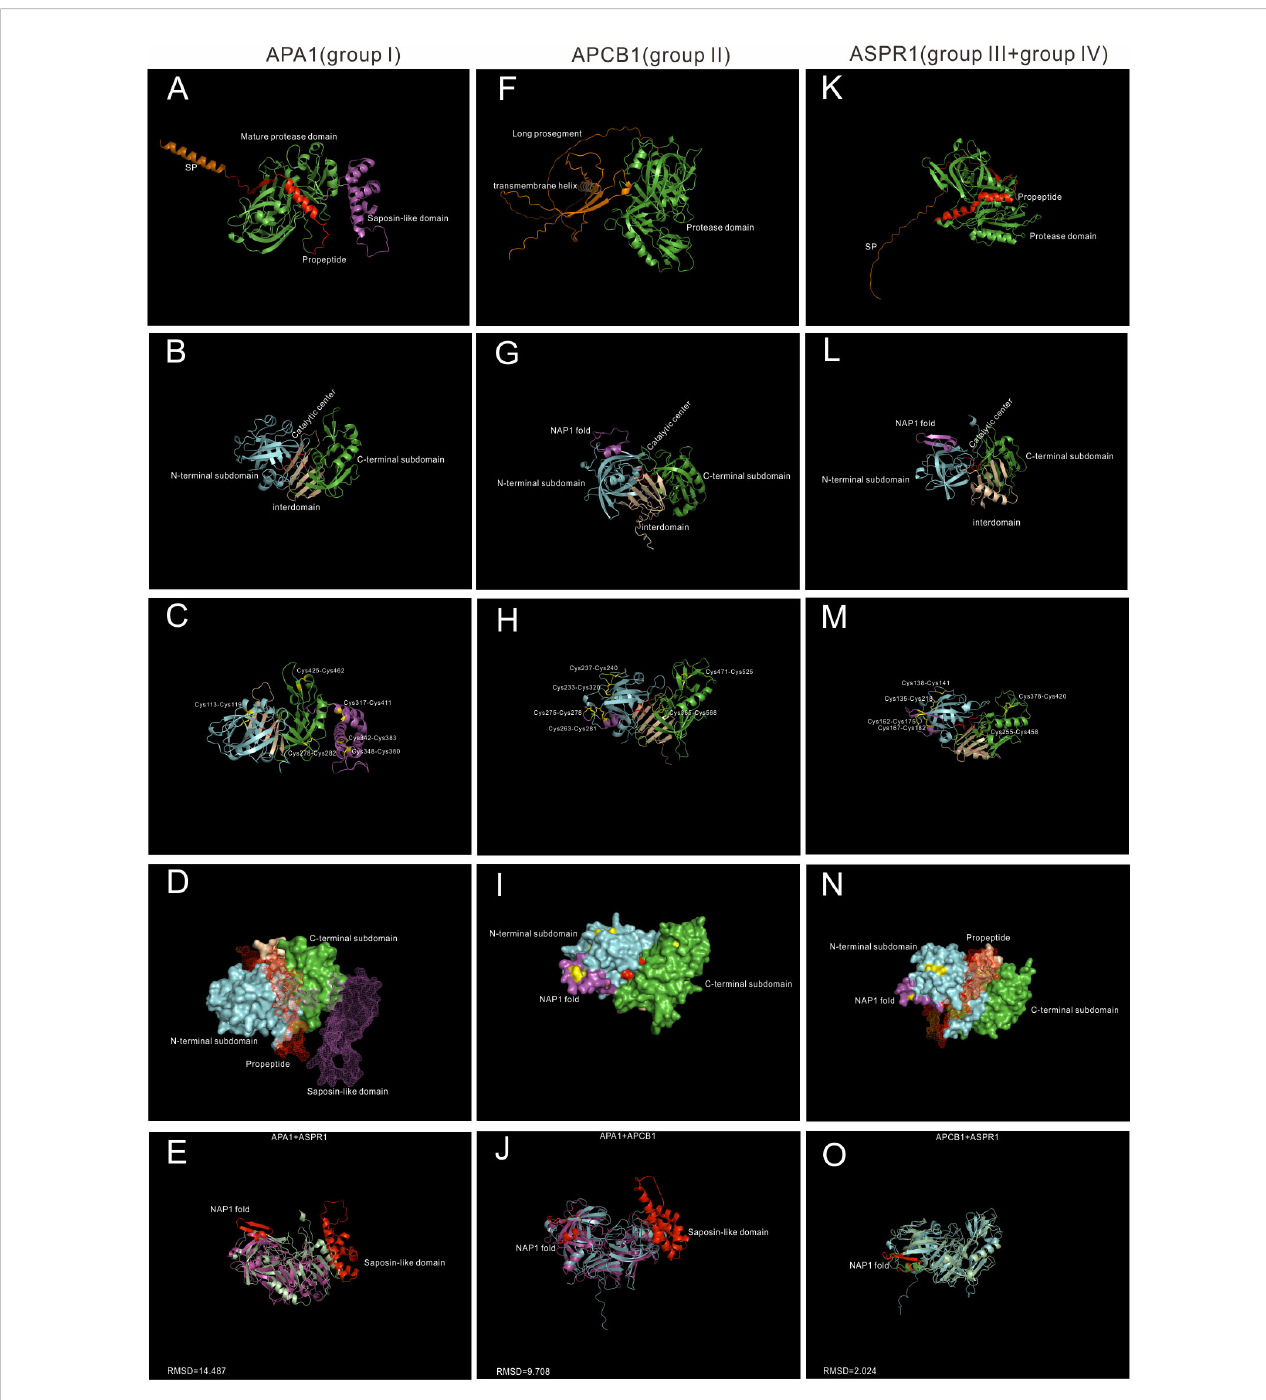
FIGURE 2 AlphaFold predicted structure models of Group I-IV. (A – D) Group I typical structure (APA1). (A) overall structure of APA1. SP,signal peptide, is colored by orange; propeptide is colored by red, saposin-like domain is colored by purple. (B) Proposed mature protease domain of APA1. N-terminal subdomain is colored by cyan, C-terminal subdomain is colored by green, interdomain beta-sheet is colored by wheat, and active sites are colored by red. (C) Disul fi de bonds of APA1. (D) Surface and mesh of APA. The proposed mature protease structure is presented by surface, propeptide and saposin-like domain is presented by mesh. (F – I) Group II typical structure (APCB1). (F) Overall structure of APCB1.Long prosegment is colored by orange and transmembrane helix is colored by wheat. (B) Proposed protease domain of APCB1,NAP1 fold is clored by purple. (H) Disul fi de bonds of APCB1. (I) surface of APCB1. (K – N) Group III typical structure (ASPR1). (K) Overall structure of APSR1. (L) proposed mature protease structure of ASPR1. (M) Surface of ASPR1. (N) Disul fi de bonds of ASPR1. (E – O) Superposition analysis of APA1, APCB1 and ASPR1, RMSD value are